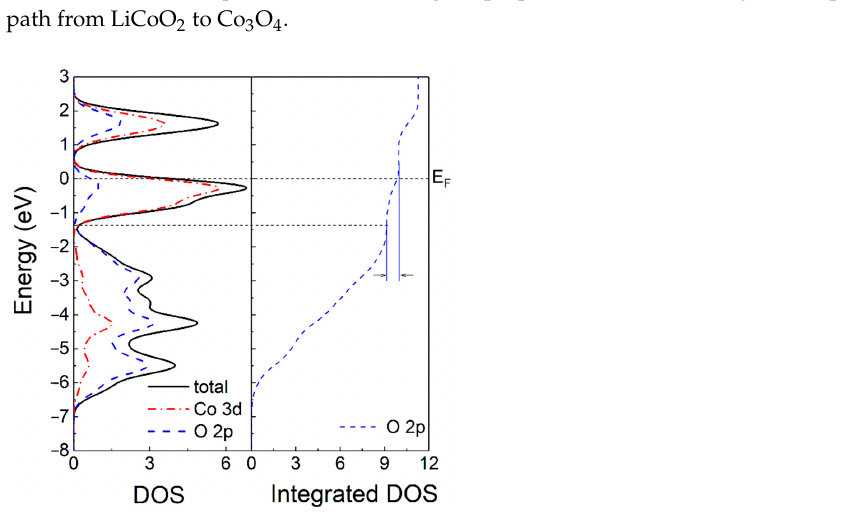
Figure 5. Calculated density of states (DOS) and integrated DOS of LiCoO 2 .